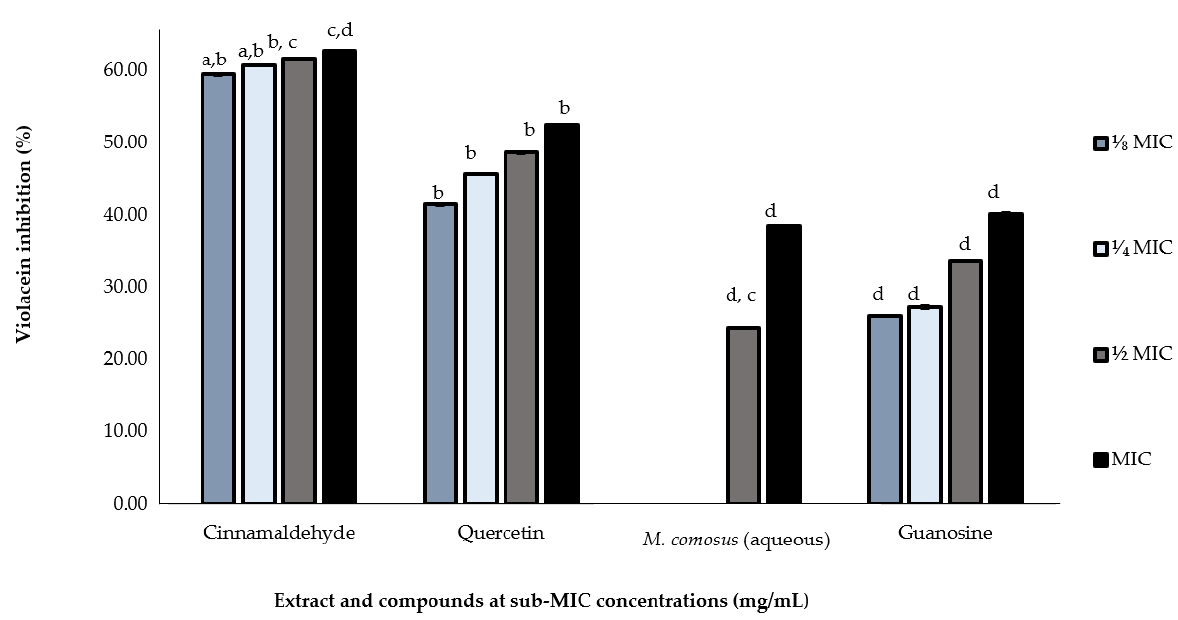
Figure 4. Quantitative violacein inhibition (%) using Melianthus comosus (aqueous) extract and guanosine against C. violaceum at concentrations between 0.190 and 1.56 mg/mL (MIC –⅟₈ MIC). Data are represented as the percentage of violacein inhibition. Control (untreated) was set as 100% production. Mean are values of triplicate independent experiments ± SD. Comparison for each concentration across the different individual treatments, presented with different letters ( a – d ) indicate significant difference at p < 0.05. Table 3. Inhibitory (IC 50 ) values of the most active plant extract and compounds against C. vio- laceum.